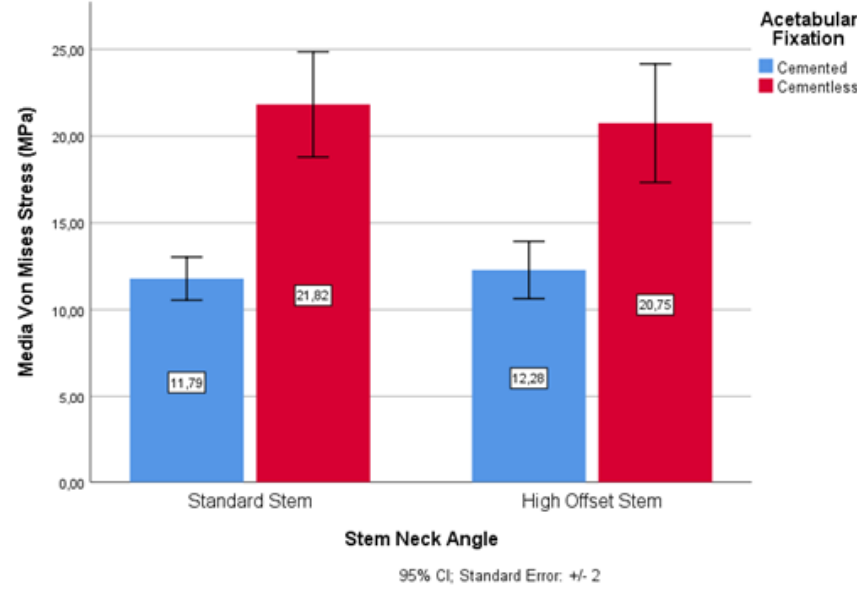
Figure 9. Wear risk through von Mises stress and stem neck